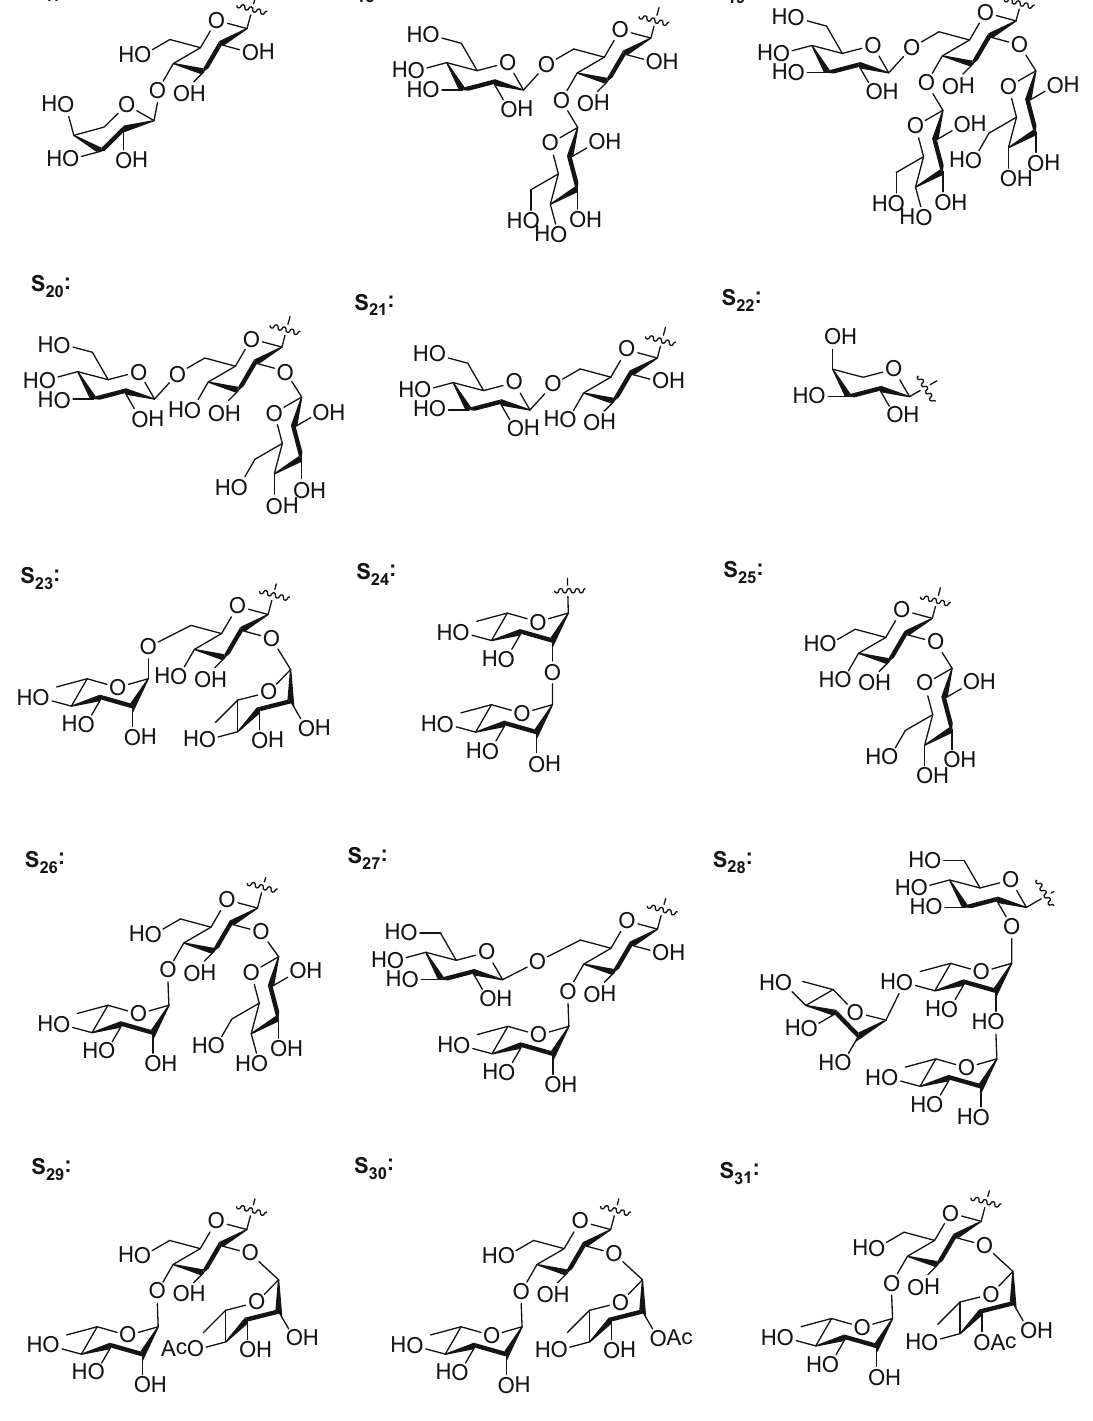
Fig. 7 Sugar residues of S 17 –S